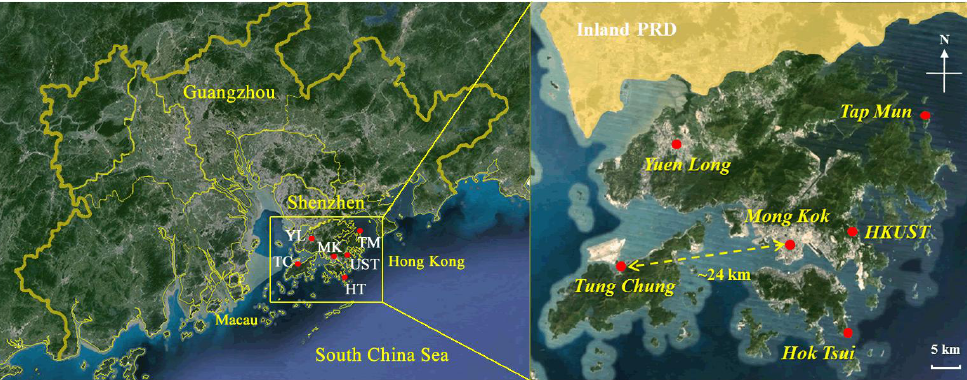
Figure 1. Location of the sampling sites and surrounding environments. Guangzhou and Shenzhen are the two biggest cities in the inland PRD region with a population of over 10 million for each city. Hok Tsui (HT) and Tap Mun (TM) are regional background sites. The Hong Kong University of Science and Technology (HKUST) is an Air Quality Research Supersite located in a suburban area. Yuen Long (YL) is a typical urban site adjacent to main traffic roads and surrounded by residential and industrial blocks. Mong Kok is a typical downtown roadside site with high traffic